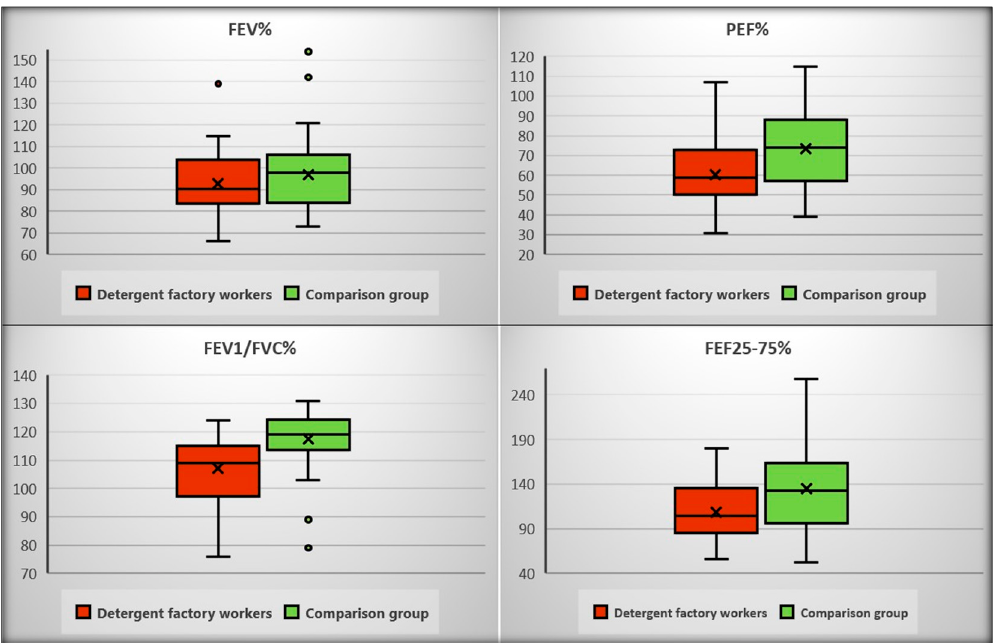
Figure 1. Comparison of spirometry parameters (FEV1%, PEF%, FEV1/FVC%, and FEF 25–75%) between detergent factory workers and the comparison group.